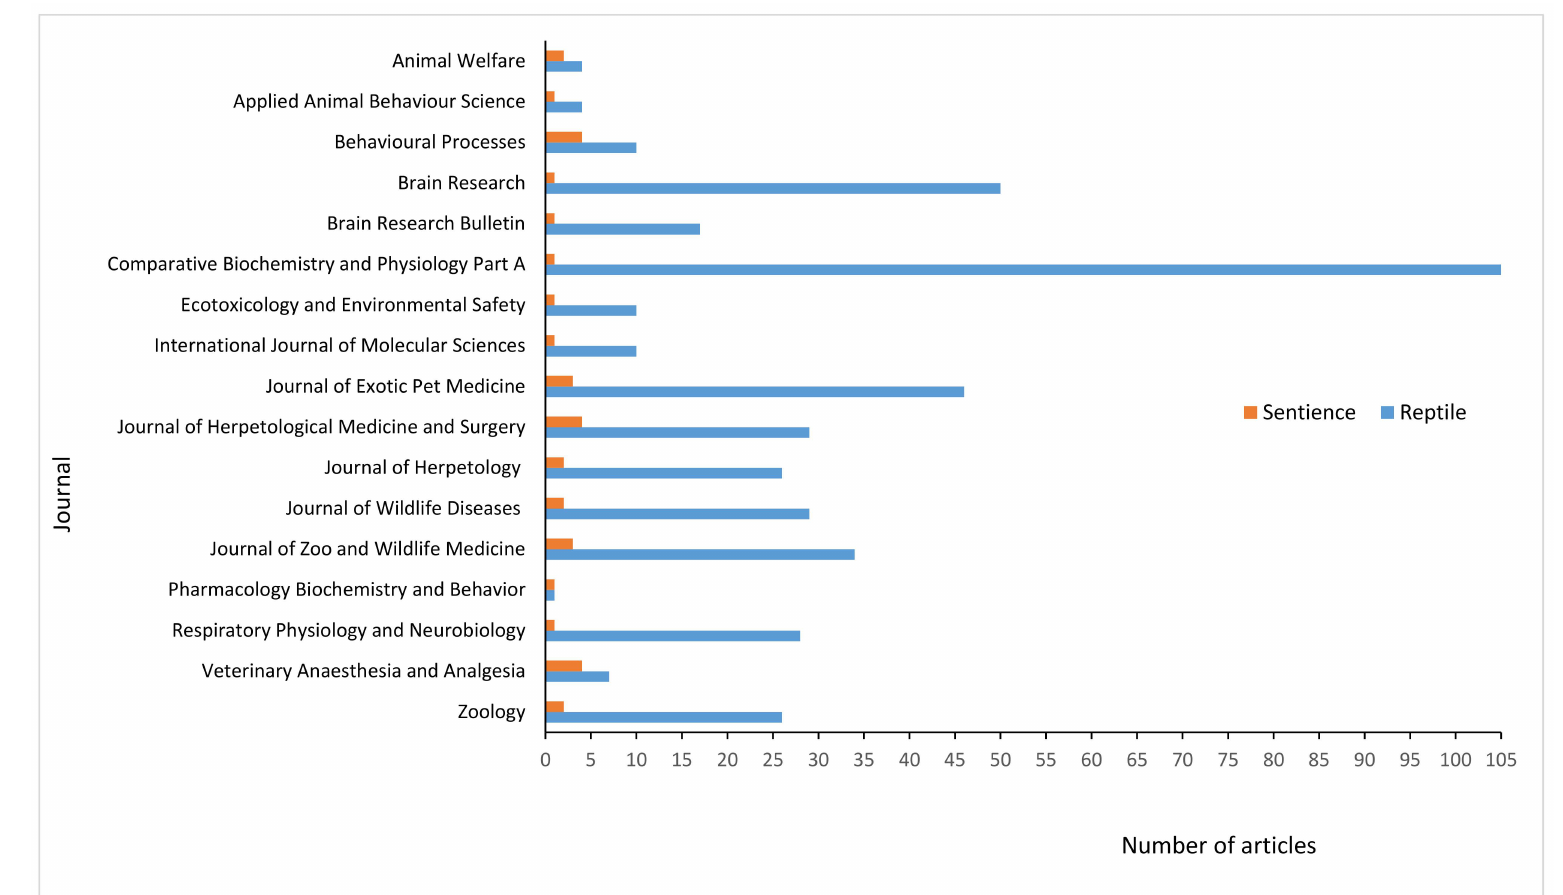
Figure 2. The total number of returned articles exploring and assuming sentience in reptiles between 1999 and 2018 from five sources (Science Direct, Ingenta Connect, PLOS ONE, BioOne, and MDPI), and the total number of articles featuring the word ‘reptiles ‘in the abstract, title, or keywords for each